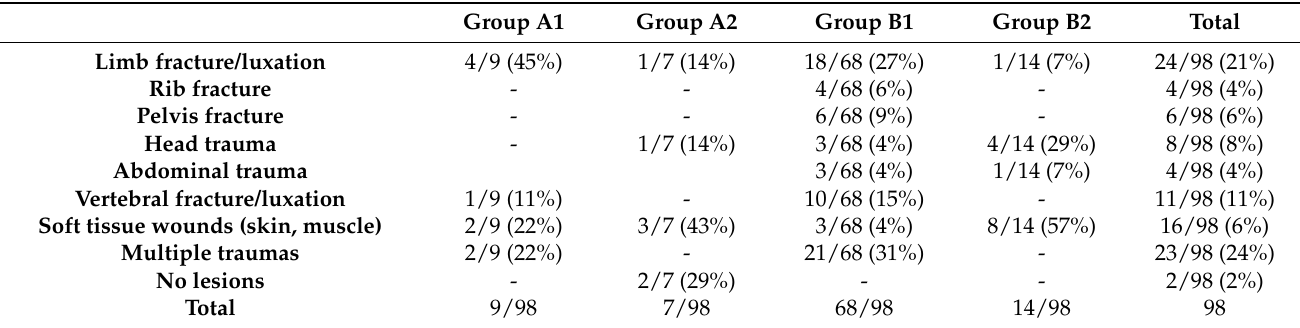
Table 3. Clinical lesions diagnosed in the cohort of 98 patients and categorised into groups. Group A1: deceased unweaned; Group A2: survived unweaned; Group B1: deceased weaned; Group B2: survived